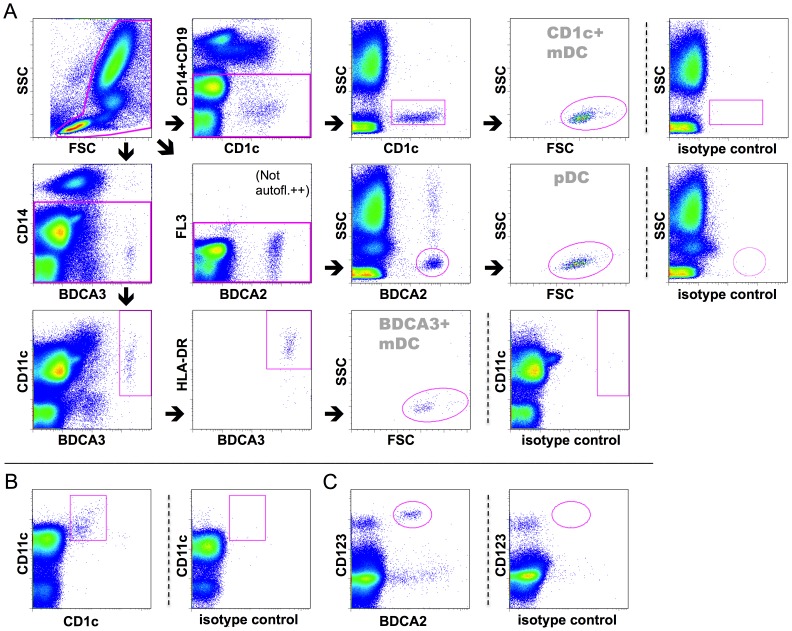
Gating strategy for flow cytometry.DC subtypes were identified for cell surface molecule analyses as shown. An example of the leukocyte gating first applied for all DC subsets is shown in the upper left corner (A). In pSTAT measurements, CD11c and CD123 were utilized as additional markers for CD1c+ mDCs (B) and pDCs (C), respectively; otherwise, a gating strategy similar to the cell surface marker protocol was used. A representative example of a healthy control is shown.